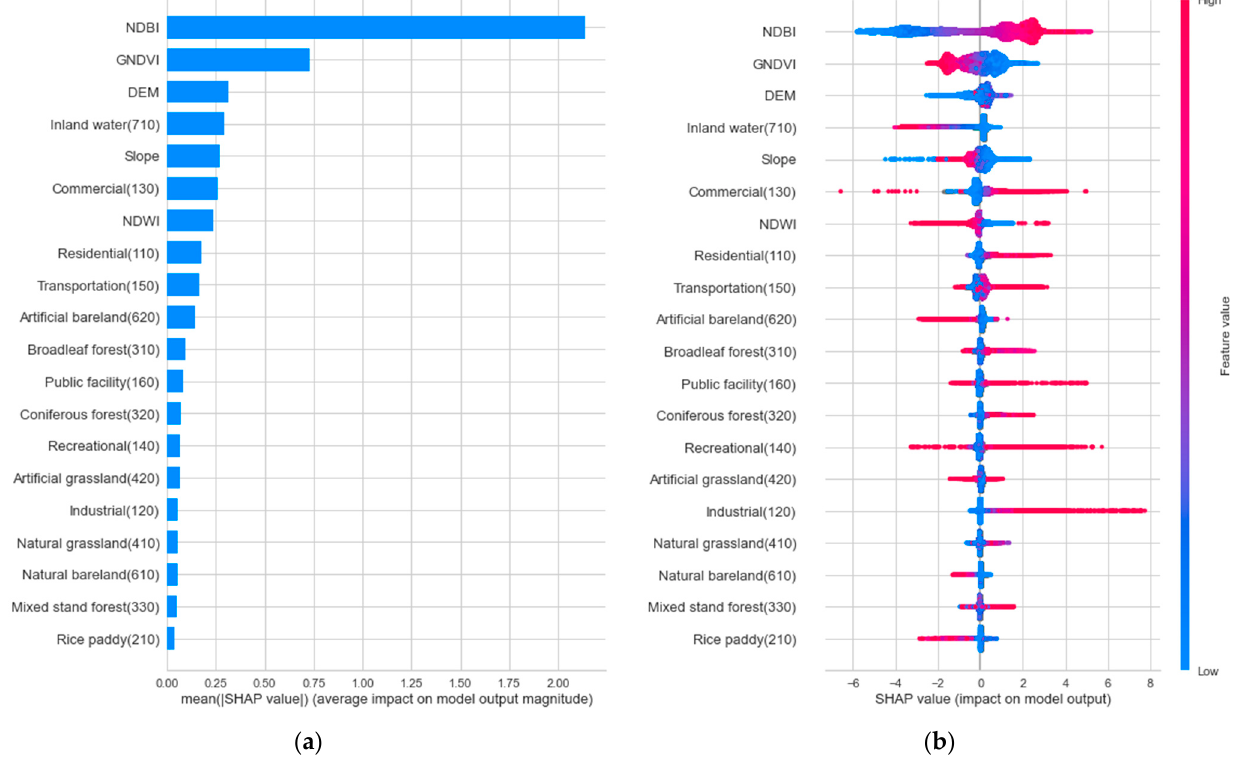
Figure 7. ( a ) Relative importance and ( b ) direction of independent variables.